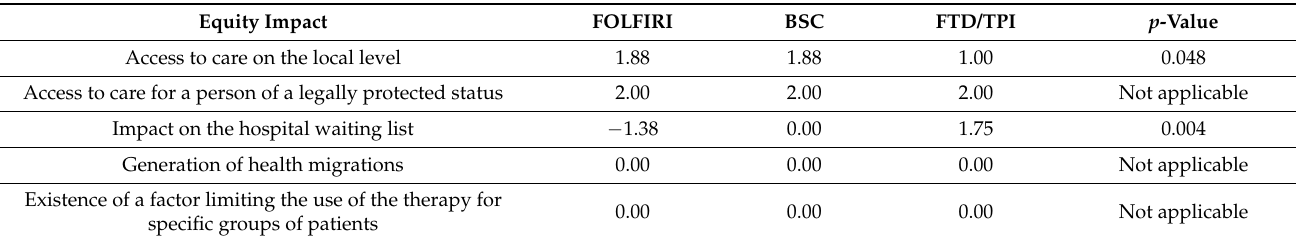
Table 6. Analysis of the qualitative